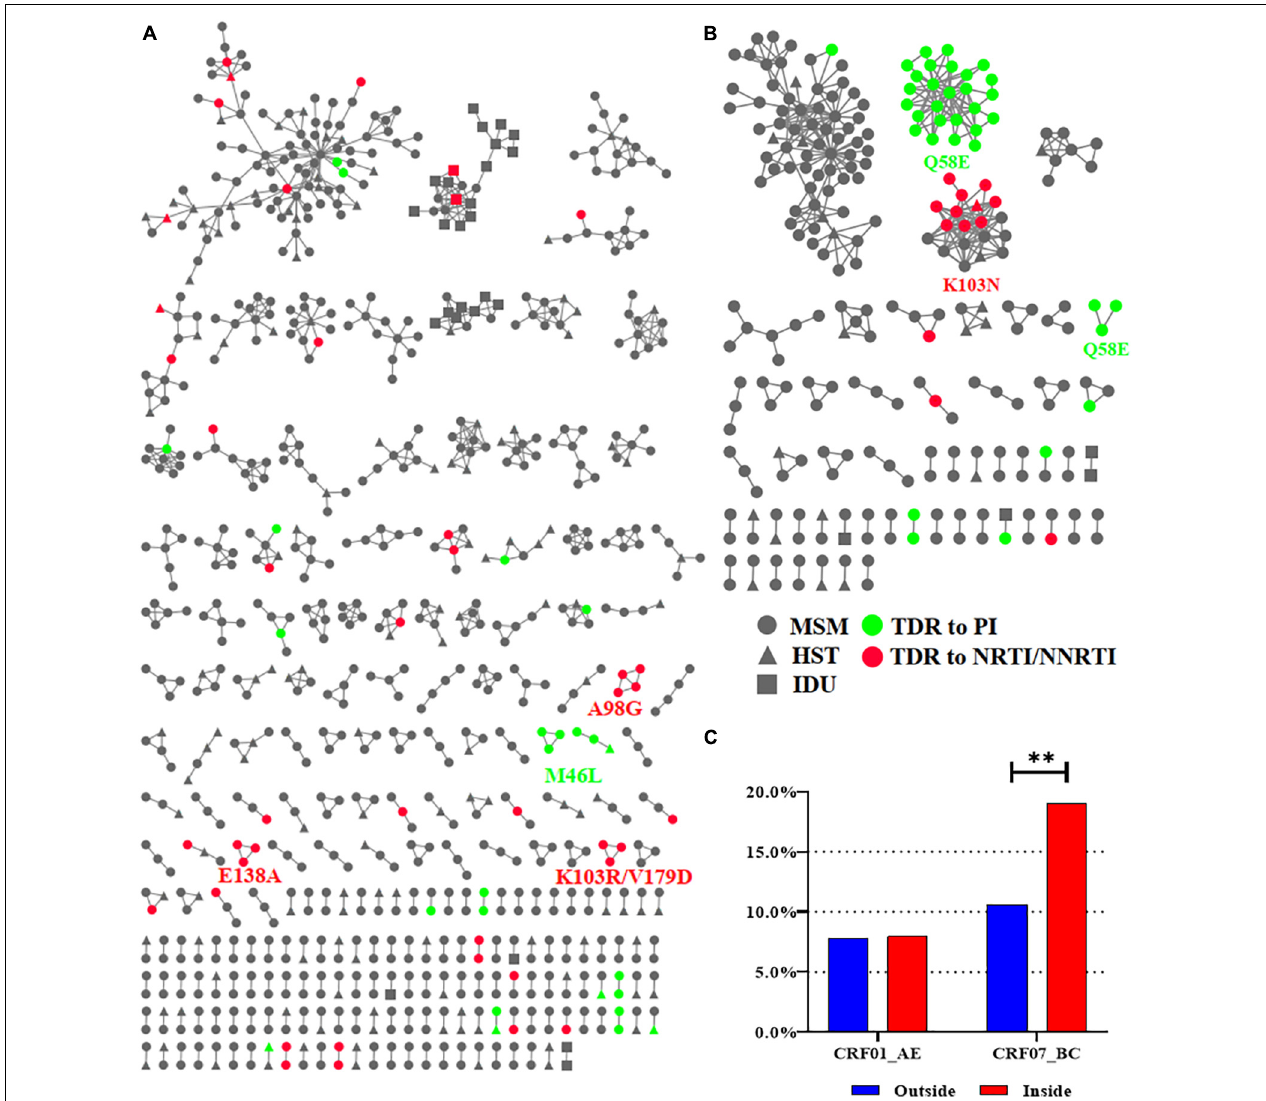
FIGURE 4 | The CRF01_AE and CRF07_BC molecular networks. (A) The molecular network of CRF01_AE. (B) The molecular network of CRF07_BC. (C) Comparison of the proportion of TDR inside and outside the network. Only clusters containing ≥ 3 individuals with the same TDR mutation were identified for the HIVDR transmission cluster and were labeled with the name of mutations. Two asterisks represented statistically significant. MSM, men who have sex with men; HST, heterosexual transmission; IDU, injected drug user; TDR, transmitted drug resistance; PI, protease inhibitor; NRTI, nucleoside reverse transcriptase inhibitor; NNRTI, non-nucleoside reverse transcriptase